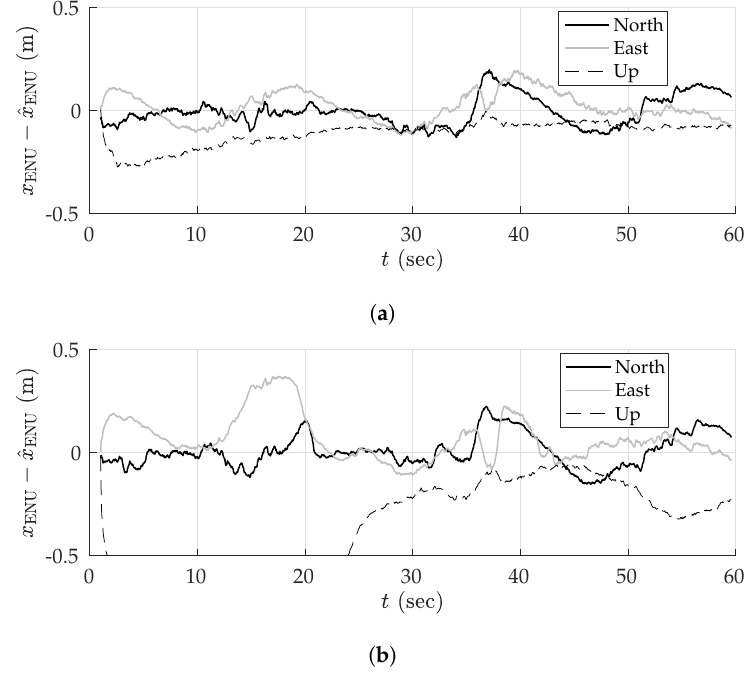
Figure 5. Mean position error in the east-north-up (ENU) frame over 1000 sessions due to multipath. ( a ) Ideal multipath exclusion. ( b ) Normalized innovation statistic (NIS)-based multipath exclusion. The black, gray, and dashed-black lines represent the error in the east, north, and up directions, respectively. The up error in the bottom panel reached a maximum magnitude of 1.75